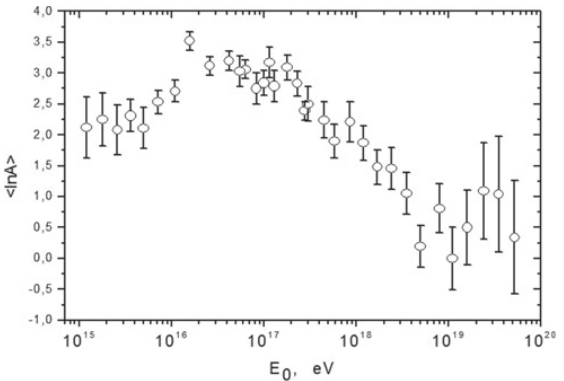
Figure 6. Estimation of MC CR with different methods using different characteristics of air showers.